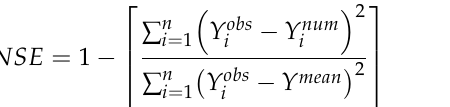
Table 2. Results of model calibration/validation.